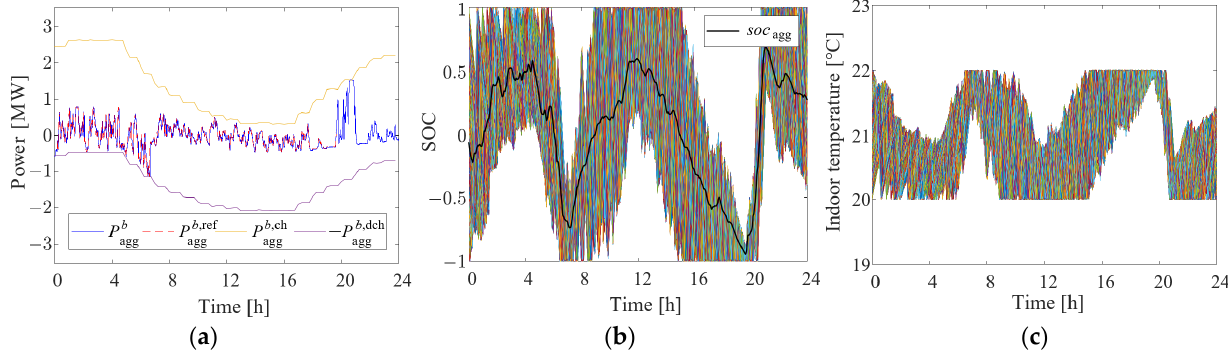
Figure 7. Tracking result of a regulation signal which keeps the constraints of the AVB model ( a ) Charge/discharge power profile. ( b ) SOC profile of VBs and AVB . ( c ) Indoor temperature profile of ACLs .